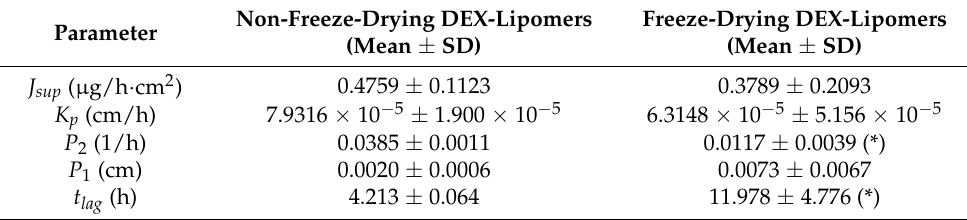
Table 9. Permeation parameters of nanoparticles before and after lyophilization.